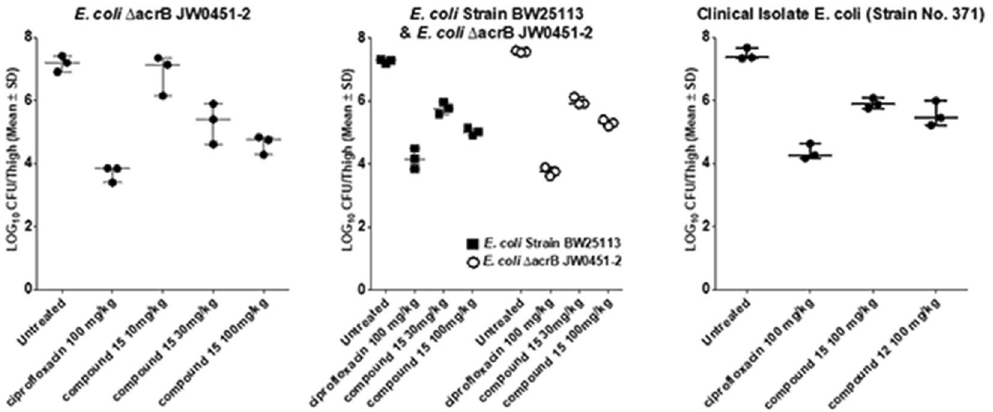
Figure 6. Animal efficacy evaluation. Bacterial load from infected thighs following per oral treatment with Ciprofloxacin 100 mg/kg or compound 15; 10, 30 or 100 mg/kg vs. E. coli ∆ acrB JW0451-2; ciprofloxacin 100 mg/kg or compound 15; 30 or 100 mg/kg vs. E. coli ∆ acrB JW0451-2 or E. coli BW25113; ciprofloxacin, compound 12 or compound 15 at 100 mg/kg tested against a recent E. coli clinical isolate strain No. 371, obtained from St. John’s Medical Hospital,